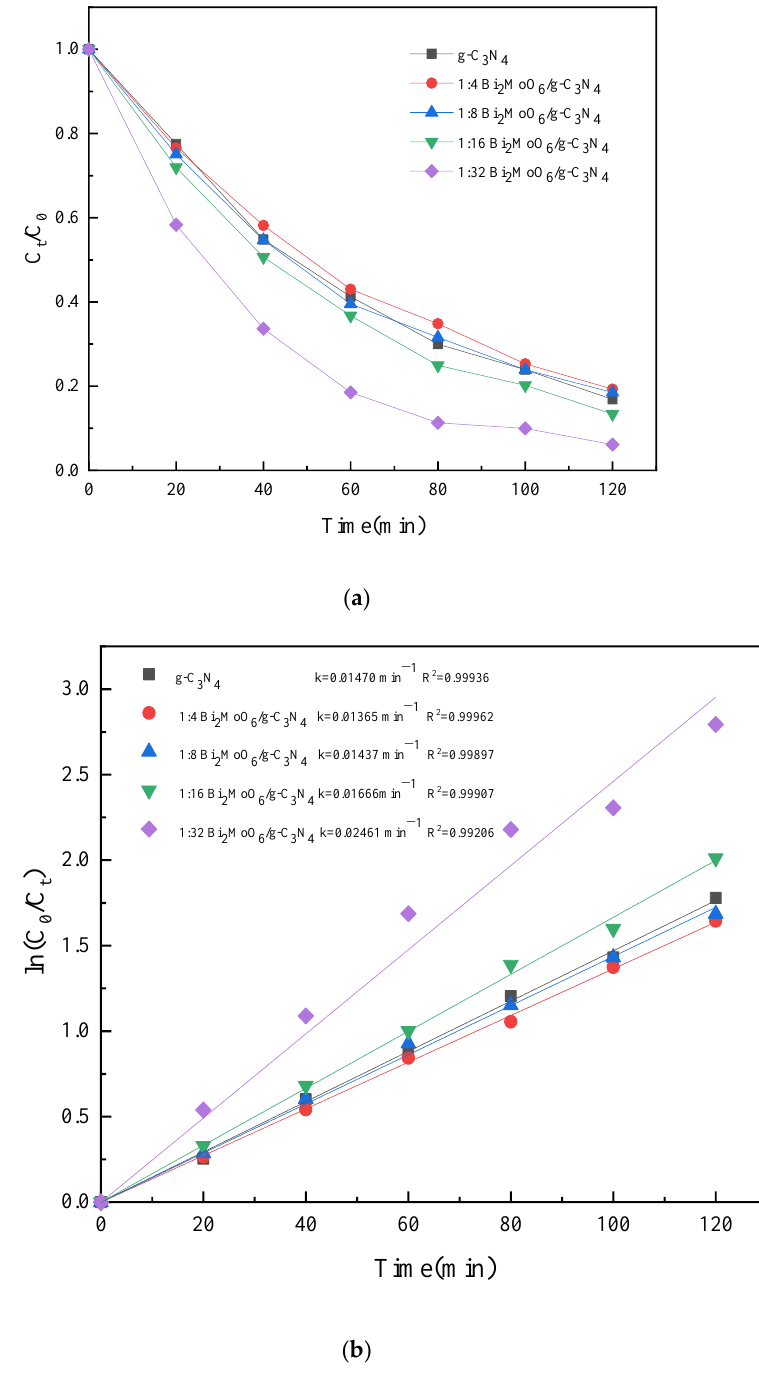
Figure 7. ( a ) Photocatalytic efficiencies of Bi 2 MoO 6 /g-C 3 N 4 with different ratios between Bi 2 MoO 6 and g-C 3 N 4 for SDZ under visible light irradiation. ( b ) Plots of ln(C 0 /C t ) versus irradiation time for SDZ.